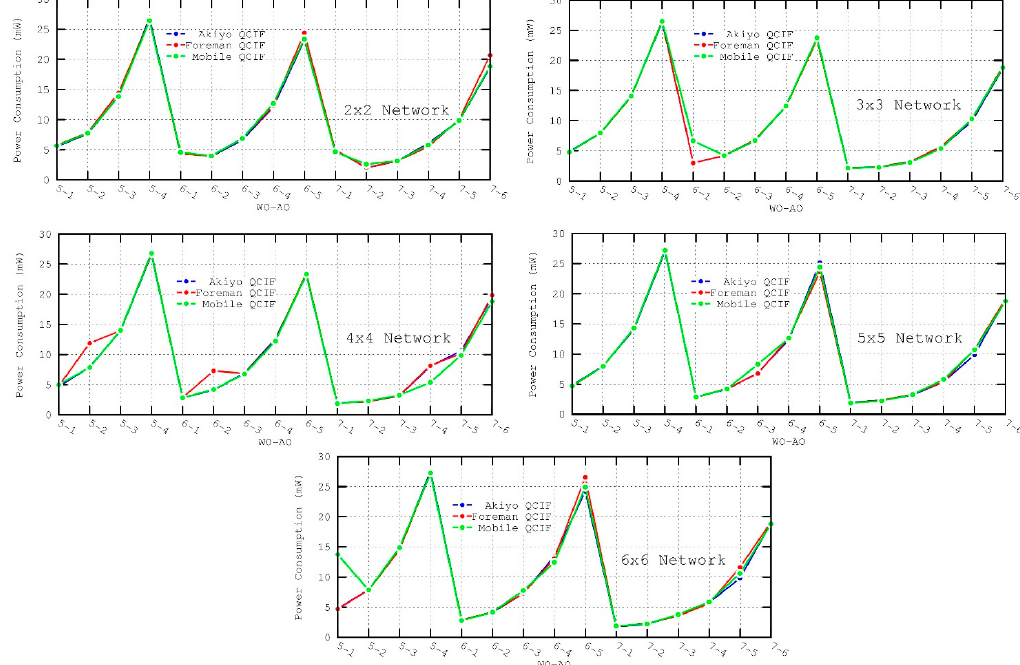
Figure 14. Power Consumption metric for the different scenarios.